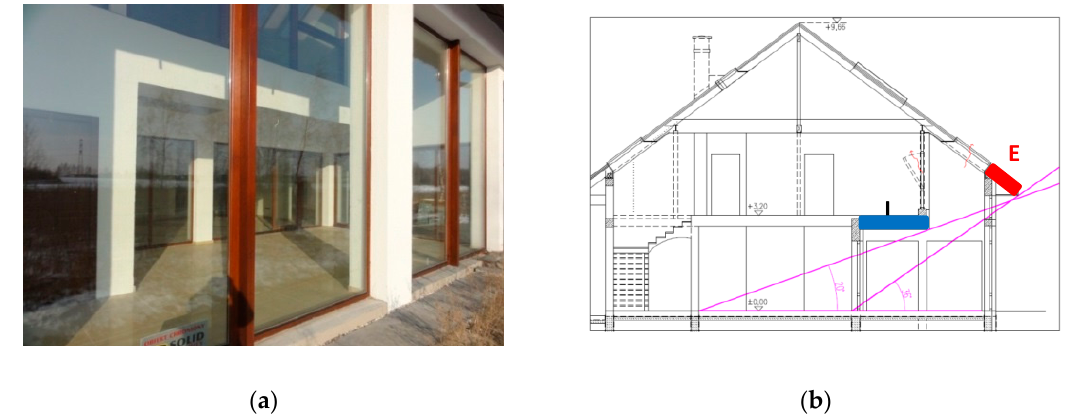
Figure 4. Architectural solar passive system: ( a ) A view of the south glazed buffer space incorporated into the house; ( b ) and a cross-section of a house along the south–north direction with apparent shading planes.